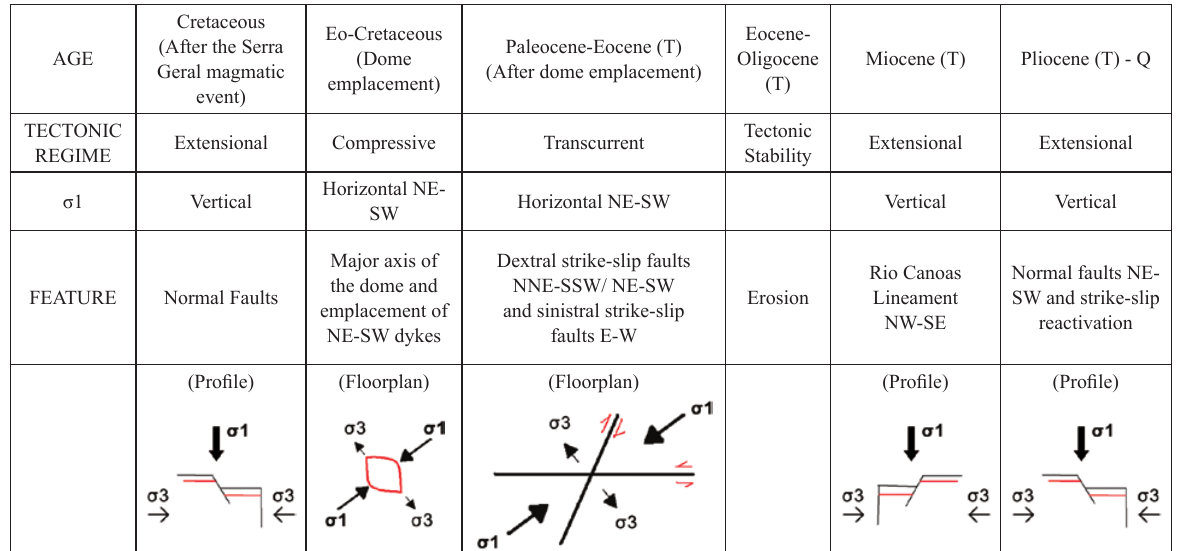
Synthesis of the structural model proposed by Roldan (2007) related to the emplacement of the Lages